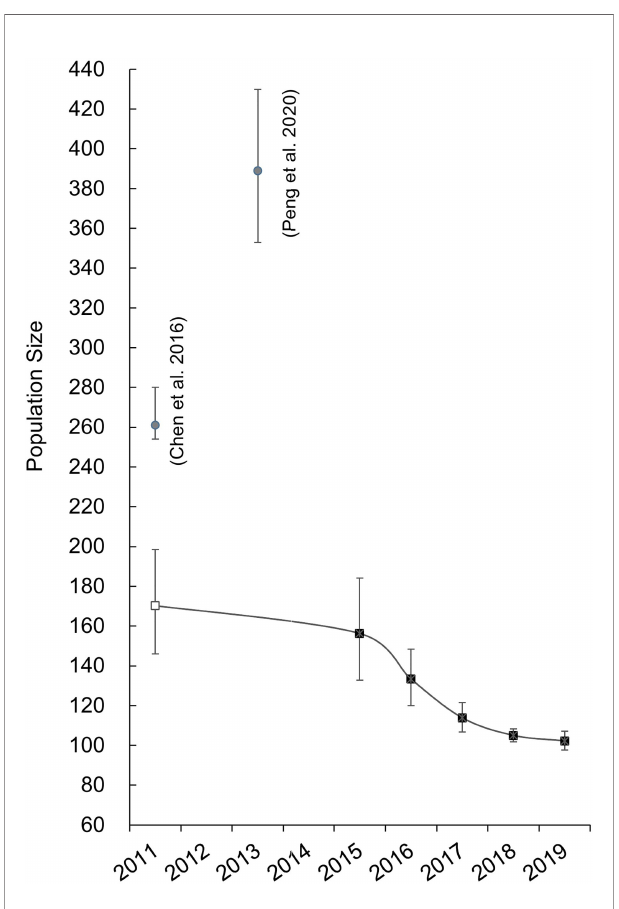
FIGURE 4 | Estimates of the total population size of the DRE Indo-Paci fi c humpback dolphins (squares). The estimates of two previous studies (solid circles) were also presented here for comparison (Chen et al., 2016; Peng et al., 2020). The one provided by Chen et al. (2016) was readjusted (hollow square) using the overall mark ratio of the present study (see main text for detailed